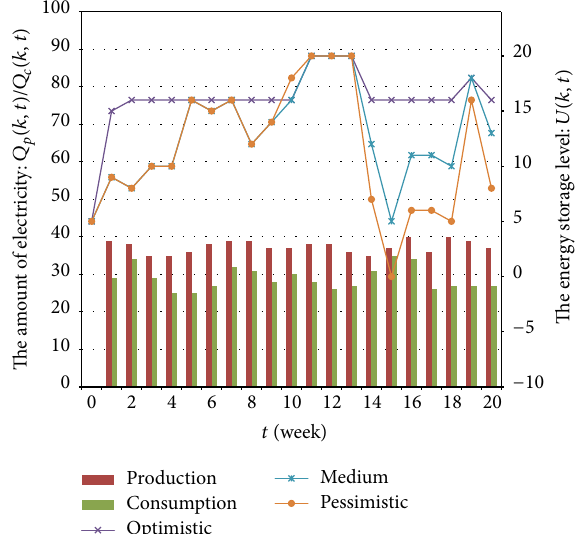
Figure 3: Trend of energy storage level at microgrid